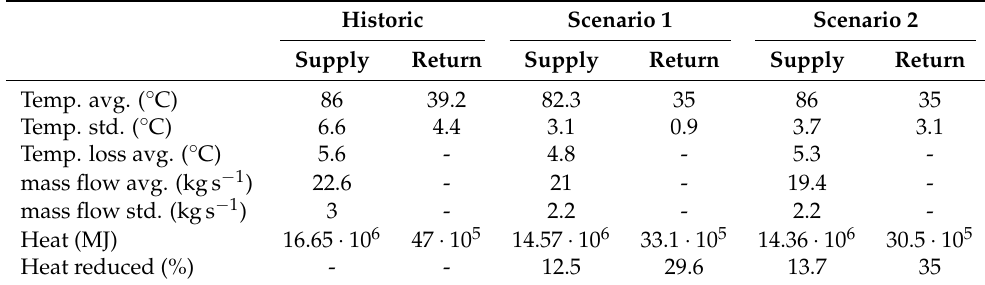
Table 1. Performance comparison for the two observed